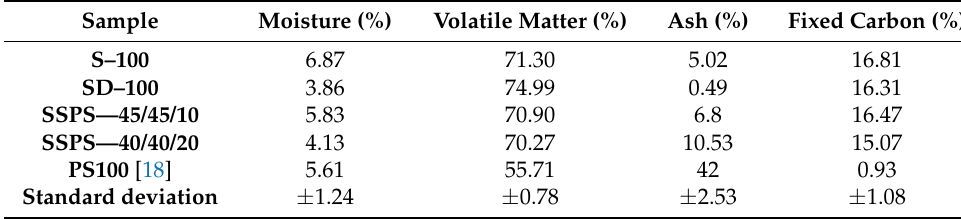
Table 1. Proximate analysis of